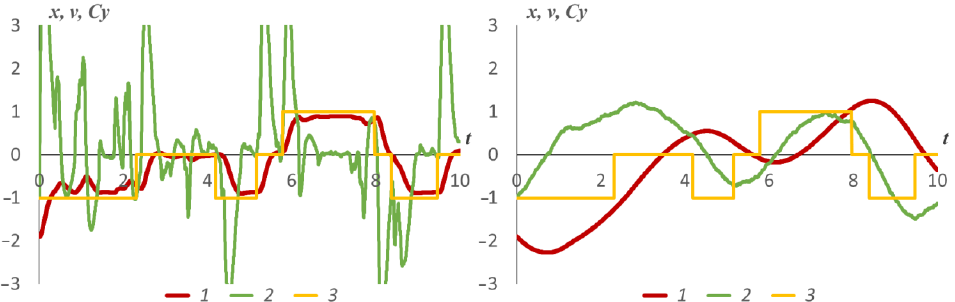
Figure 3. Typical state trajectories of the model with and without control u t : 1—coordinate x t ; 2—velocity v t ; 3—desired “ideal” trolley movement Cy t